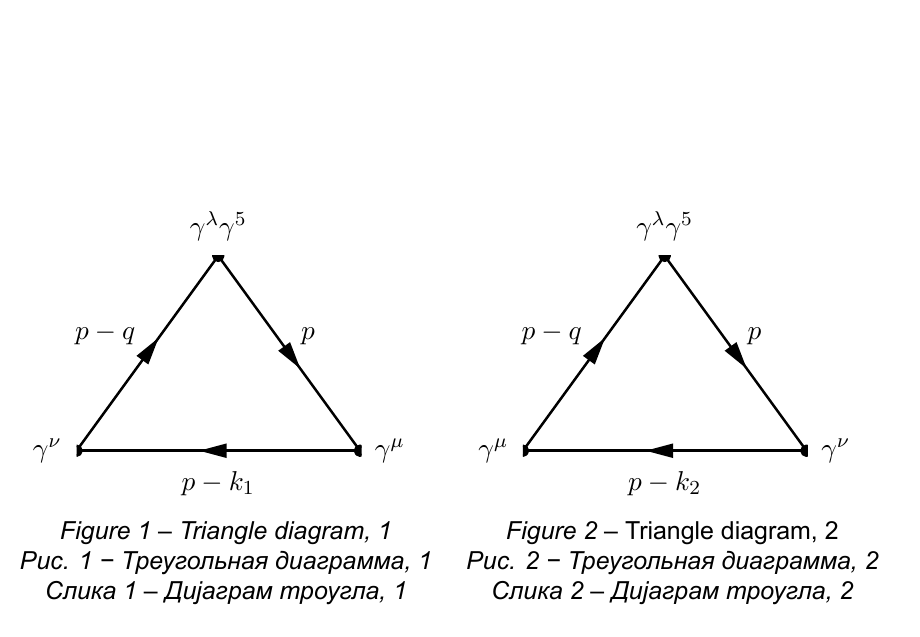
Figure 2 – Triangle diagram, 2 Рис. 2 − Треугольная диаграмма, 2 Слика 2 – Дијаграм троугла,